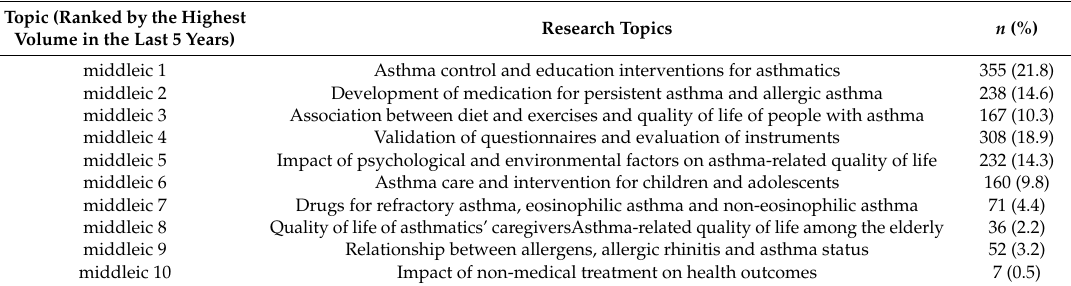
Table 4. Ten research topics classified by LDA.